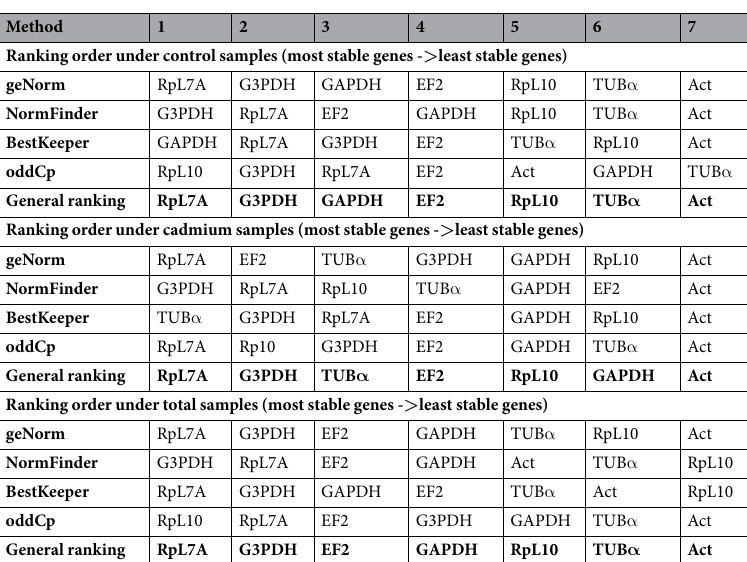
Table 1. Expression stability ranking of the 7 candidate reference genes.